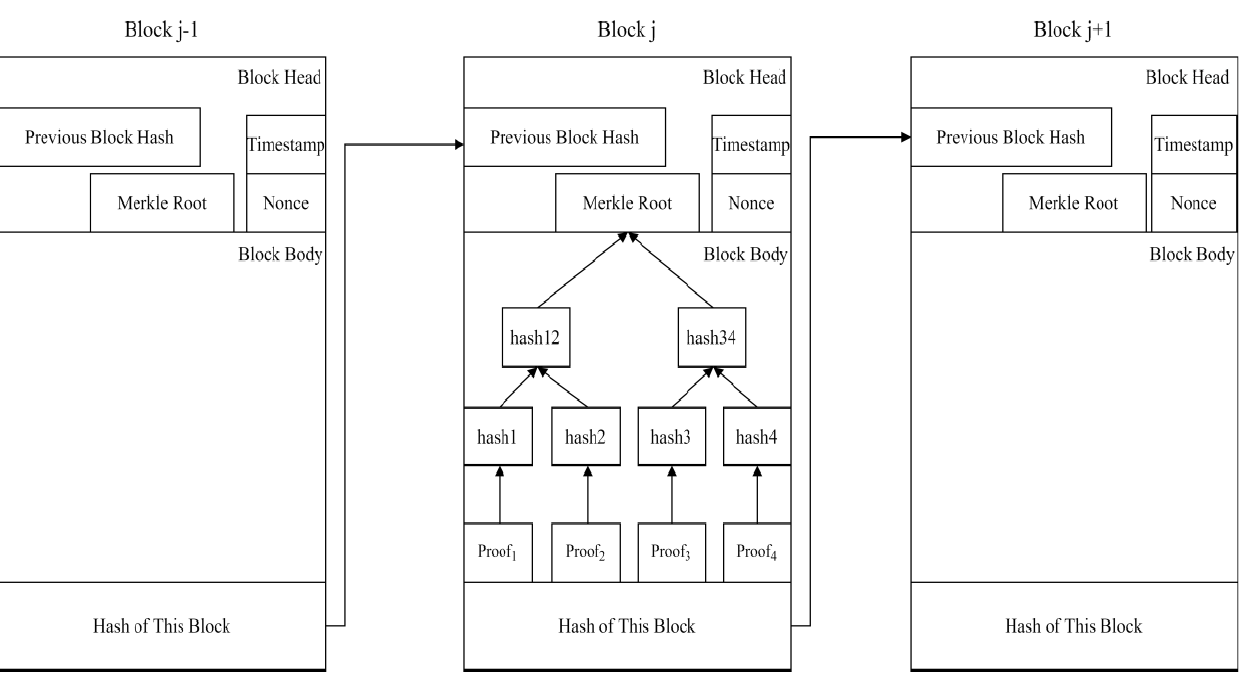
Figure 4. Structure of the deletion verification chain.